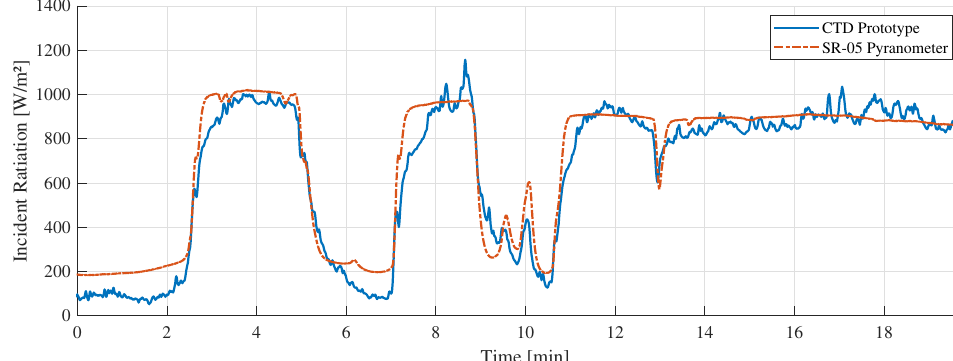
Figure 17. “C” measurement with cloudy weather conditions.